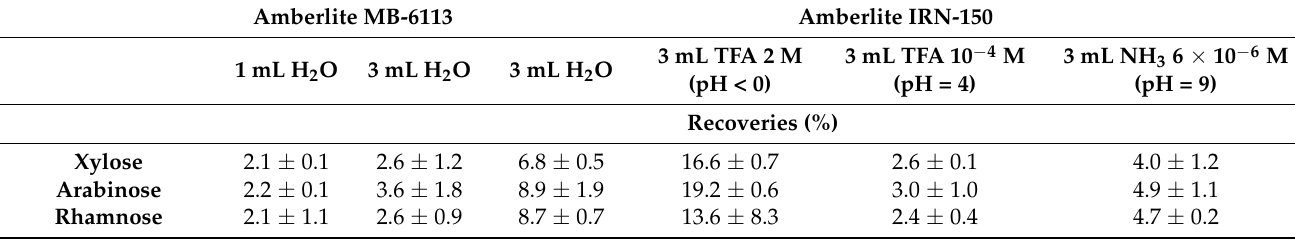
Table 2. Recoveries obtained for a standard solution of 7 monosaccharides and 2 uronic acids (each at 10 ppm) with Amberlite MB-6113 and IRN-150 resins under different elution conditions. For the percentage recoveries, the relative confidence interval is reported. Each experiment was conducted in